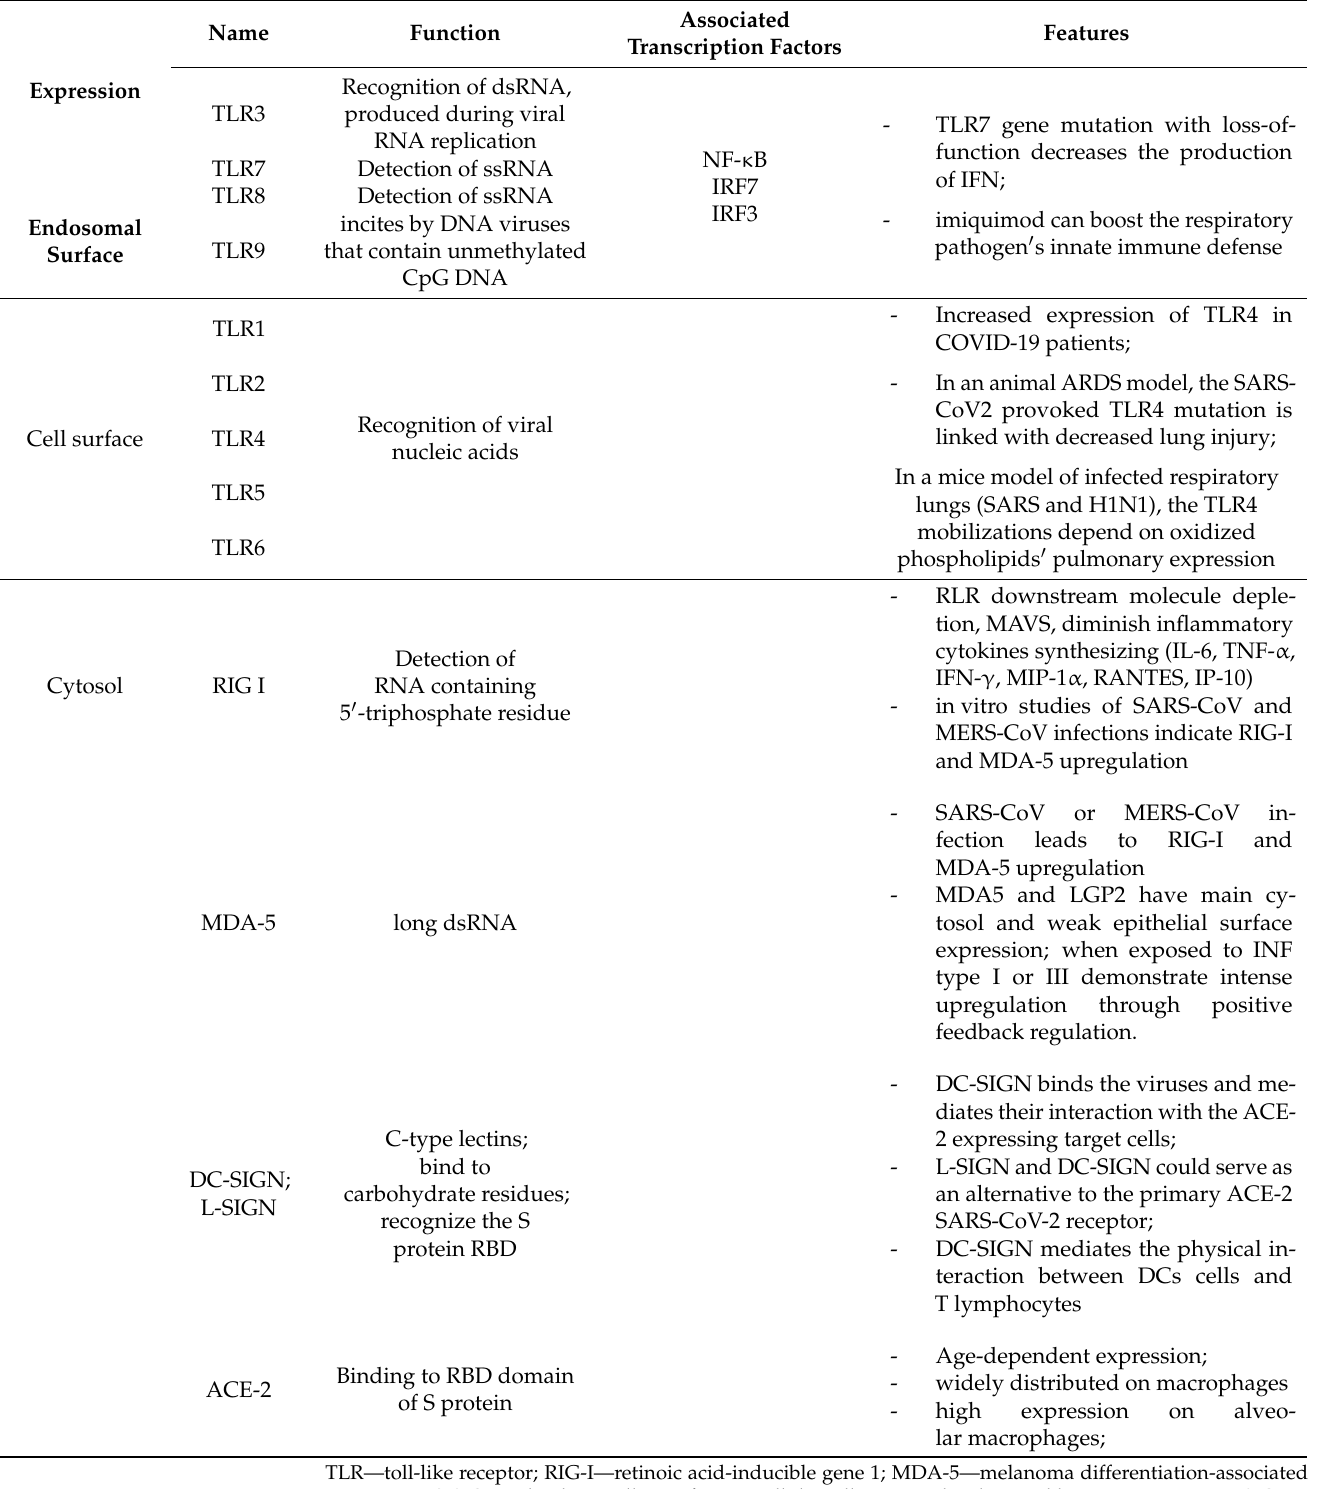
Table 2. Receptors associated with SARS-CoV-2 infection in children and adults